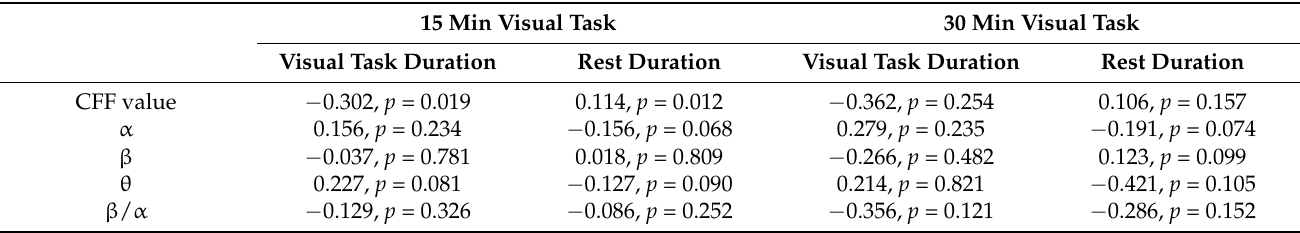
Table 6. Spearman correlation analysis results between the four relative EEG power indices and the CFF value for the visual task duration and rest